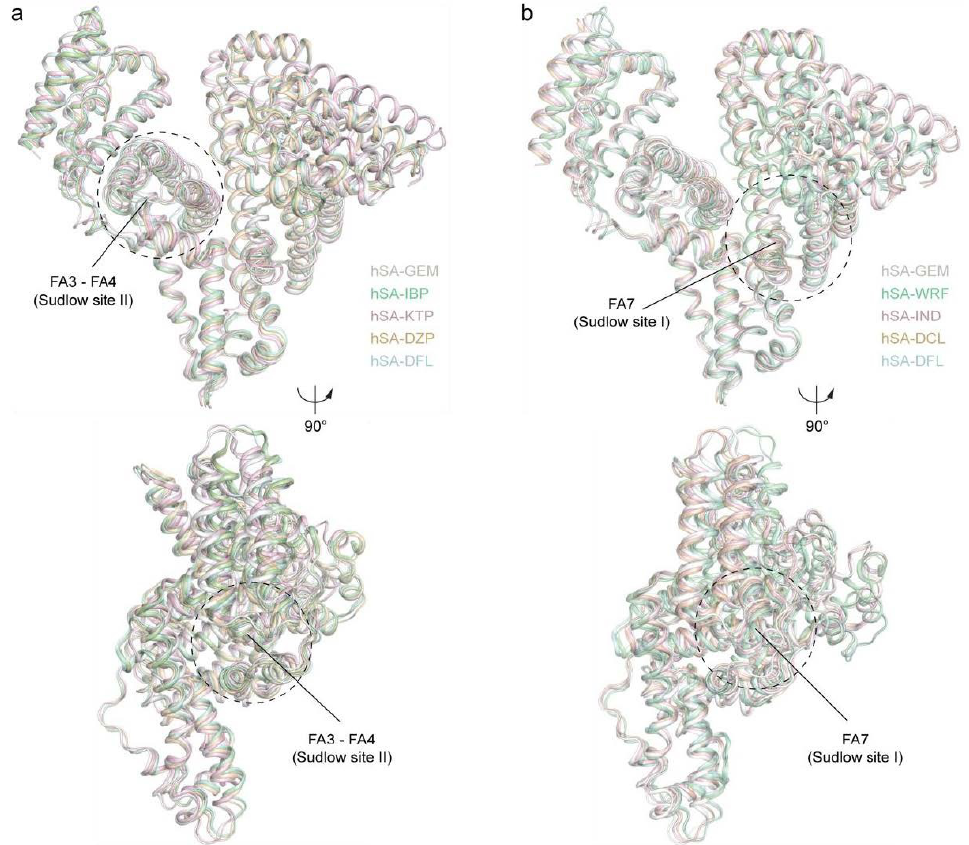
Figure 3. Structural comparison of different HSA-drug crystal structure complexes. ( a ) Superimposed HSA-GEM com- plex (white; PDB identification code: 7QFE) aligned with HSA-ibuprofen (pale green; PDB identification code: 2BXG), HSA-ketoprofen (light pink; PDB identification code: 7JWN), HSA-diazepam (wheat; PDB identification code: 2BXF), and HSA-diflunisal (pale cyan; PDB identification code: 2BXE) complexes shown in two orientations (90° rotation); ( b ) su- perimposed HSA-GEM complex (white; PDB identification code: 7QFE) aligned with HSA-warfarin (pale green; PDB identification code: 2BXD), HSA-indomethacin (light pink; PDB identification code: 2BXM), HSA-diclofenac (wheat; PDB identification code: 4Z69), and HSA-diflunisal (pale cyan; PDB identification code: 2BXE) complexes shown in two ori- entations (90° rotation). The α -helices of HSA are represented by cartoon loops and coloured. The three-dimensional structure models were generated and rendered using Pymol [29].